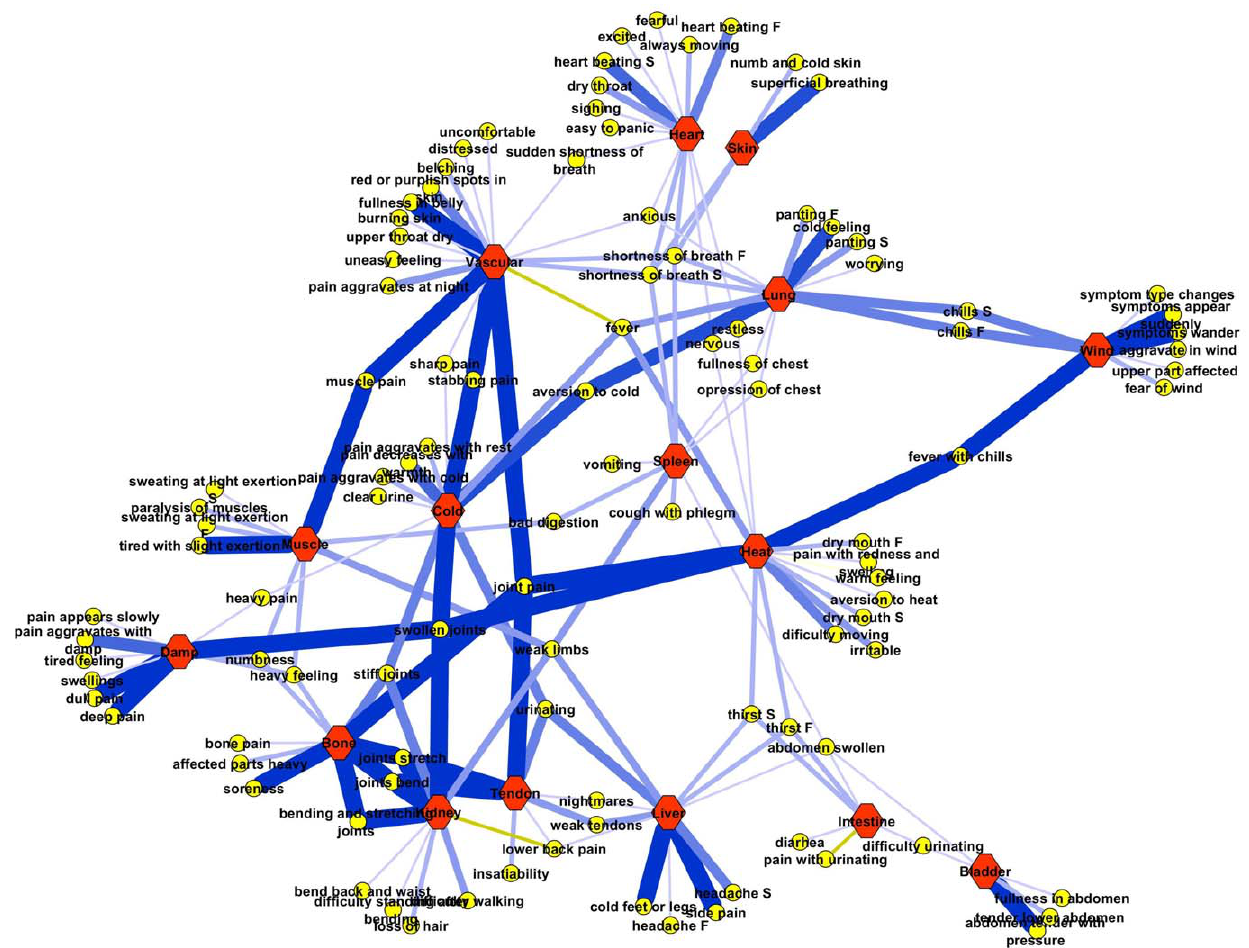
Figure 2. Example of a personalized Bi-syndromes network based on Vangermeersch 1994. The red hexagonal nodes represent the Bi- syndromes (Bi prefix was omitted for brevity), and the yellow circles represent the symptoms and signs related to the Bi-syndromes. The blue lines (edges) represent the relationships between symptoms and syndromes according to theory while the thickness of the lines represent the symptom scores of one patient. Thicker and darker colored edges denote a higher score and thinner, lighter edges denote a lower score.